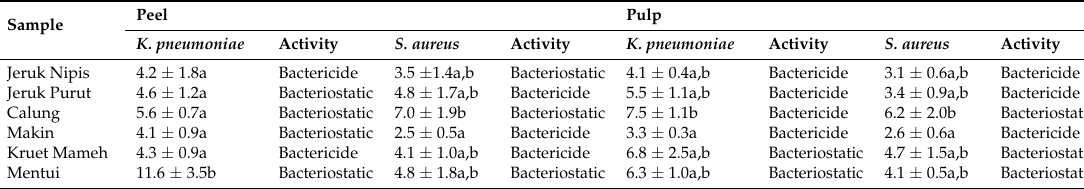
Table 4. Antibacterial activities (IC 50 : mg/mL) of peels and pulps of citrus samples from Aceh. Different letters (a,b) indicate a significant difference within the column (One Way ANOVA, post hoc Tukey’s test, p <